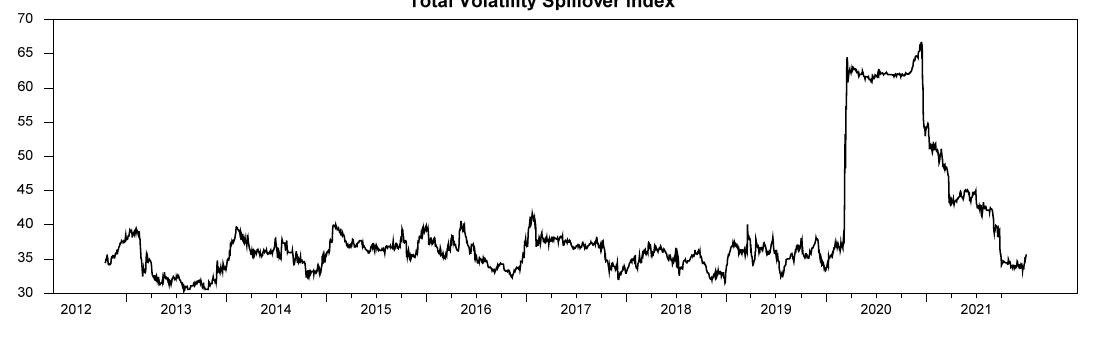
Figure 6. Total Volatility Spillover Index.